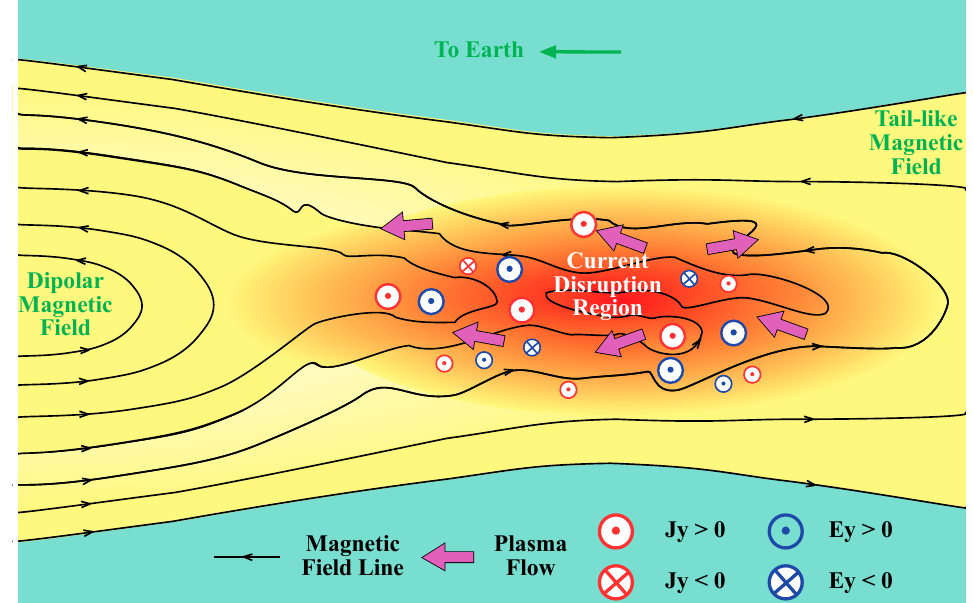
Figure 5. A schematic diagram to illustrate several features of CD. The sense of the y -component of the cross-tail current and the y -component of the electric field is indicated by the sign of Jy and Ey , respectively. The current and electric field can reverse their sign locally. The CD occurs in a closed magnetic field region unconnected to MR.